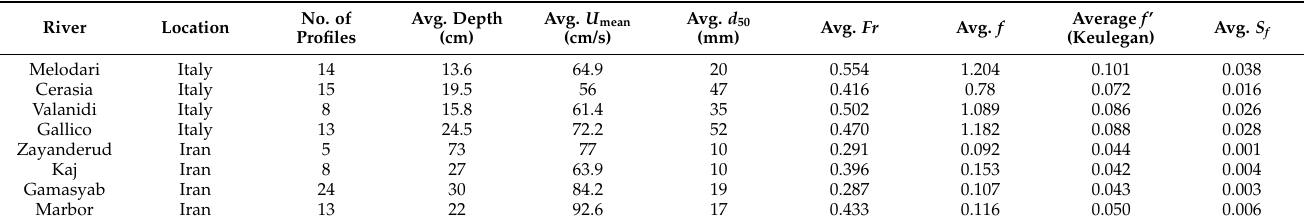
Table 1. The rivers and profiles used to derive Equation (24).